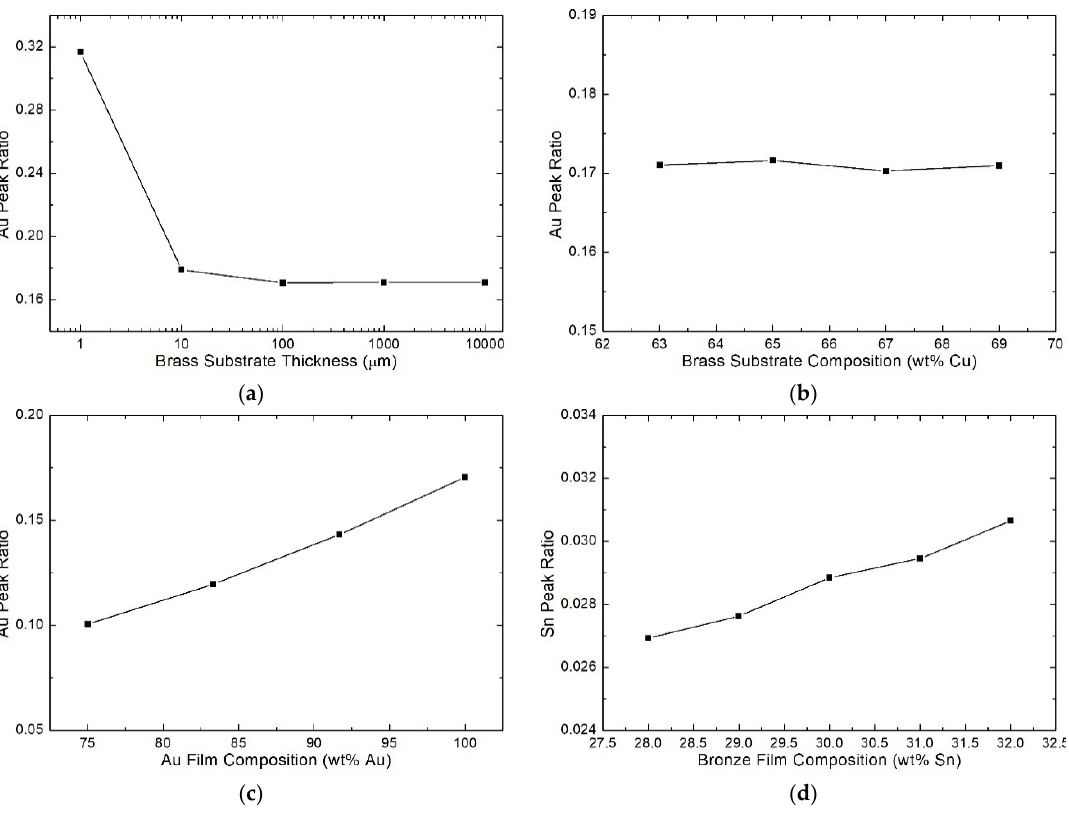
Figure 5. Dependence of Au PR of 0.5 µ m gold film on brass simulation: ( a ) on the thickness of the substrate; ( b ) on the composition of the substrate (expressed in percentage of Cu); and ( c ) on the composition of the film, increasing the amount of Cu. ( d ) Dependence of Sn PR, of 3 µ m bronze film on brass, on the composition of the film, increasing the amount of Cu.